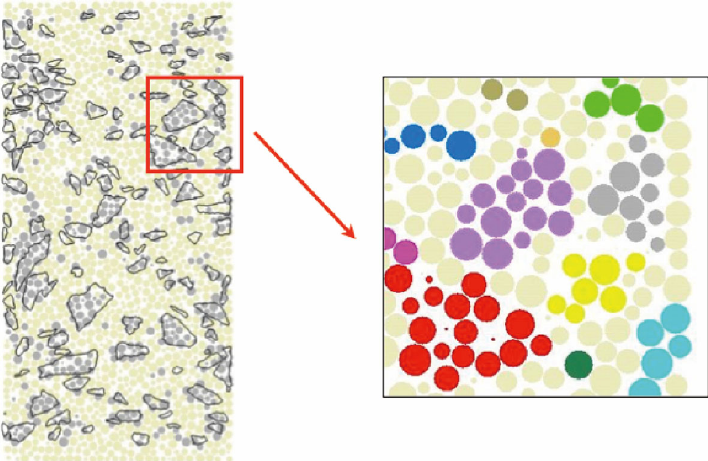
Fig. 19 Partial enlargement panel showing the positions of rock particles